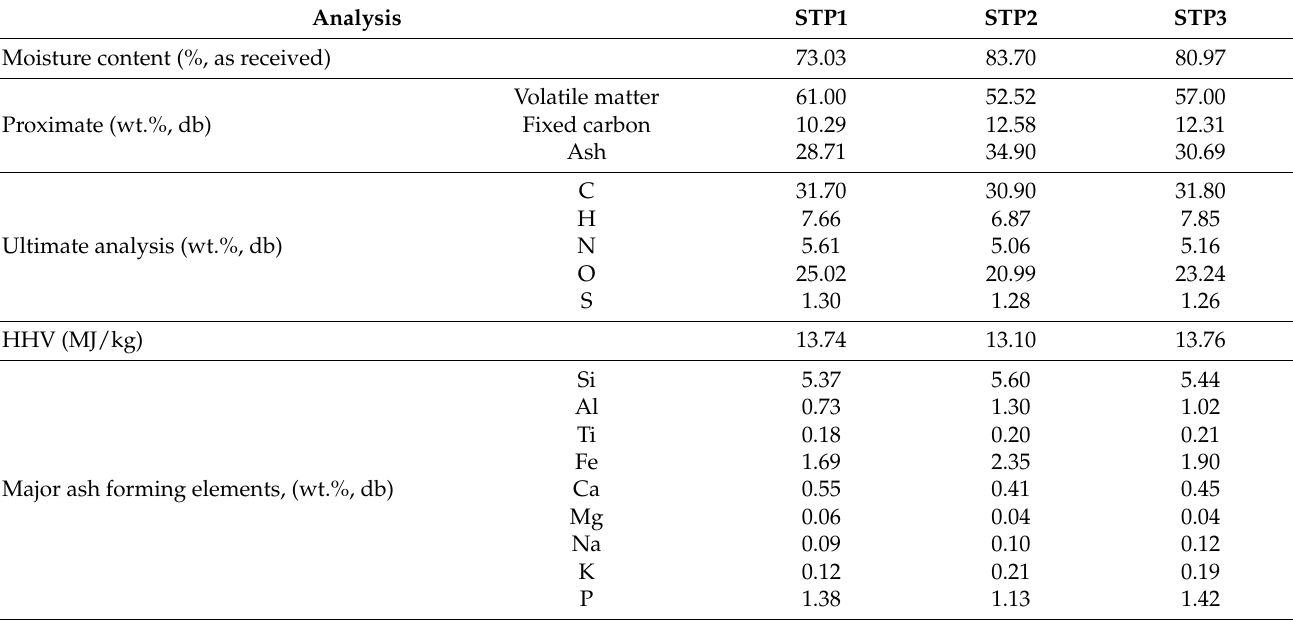
Table 2. Characteristics of dewatered sewage sludge samples.